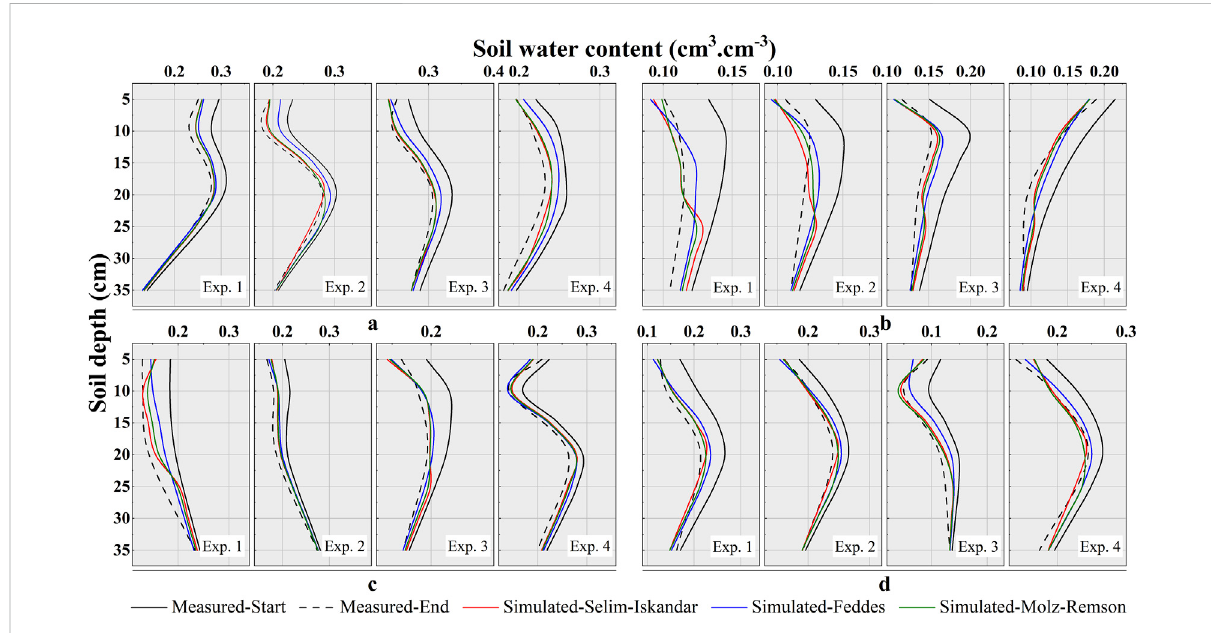
FIGURE 4 Based onthe initial soilwater content (Measured-Start), combined with theimproved Feddes model, Selim-Iskandar model, and Molz-Remson model,thesimulatedvaluesofsoilwatercontentwereobtained.Then,itiscomparedwiththemeasuredsoilwatercontent(Measured-end),toverify the accuracy and simulation performance of the model. a, b, c and d represent four experimental sites, Exp. 1, Exp. 2, Exp. 3 and exp. 4 represent different experimental periods respectively.